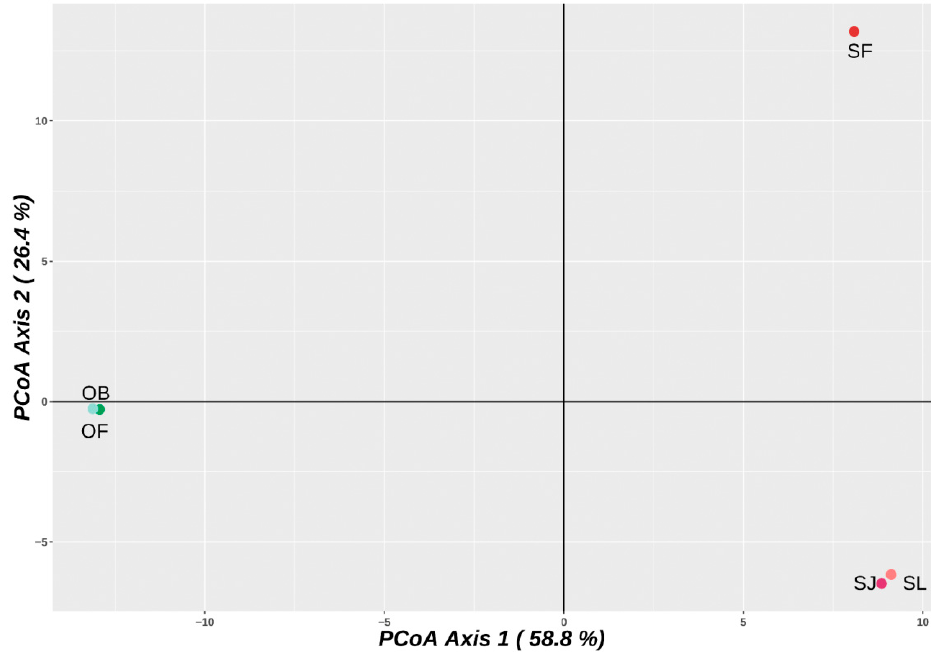
Figure 2. Principal coordinate analysis plot of genetic diversity in arowana species strongly corresponds to their geographical distribution. OB = O. bicirrhosum ; OF = O. ferreirai ; SF = S. formosus ; SJ = S. jardinii ; SL = S. leichardti.